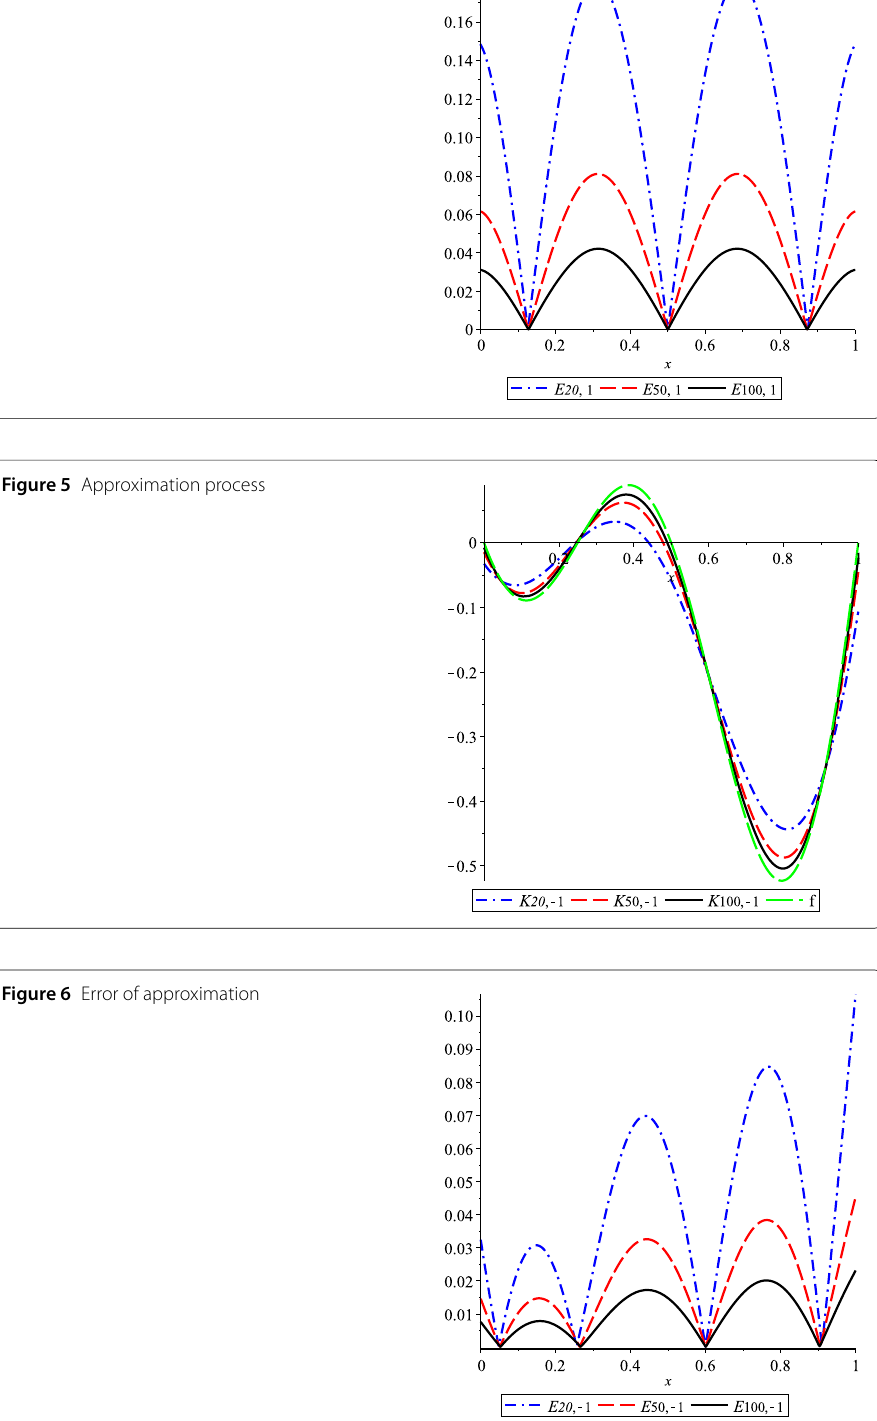
Figure 4 Error of approximation